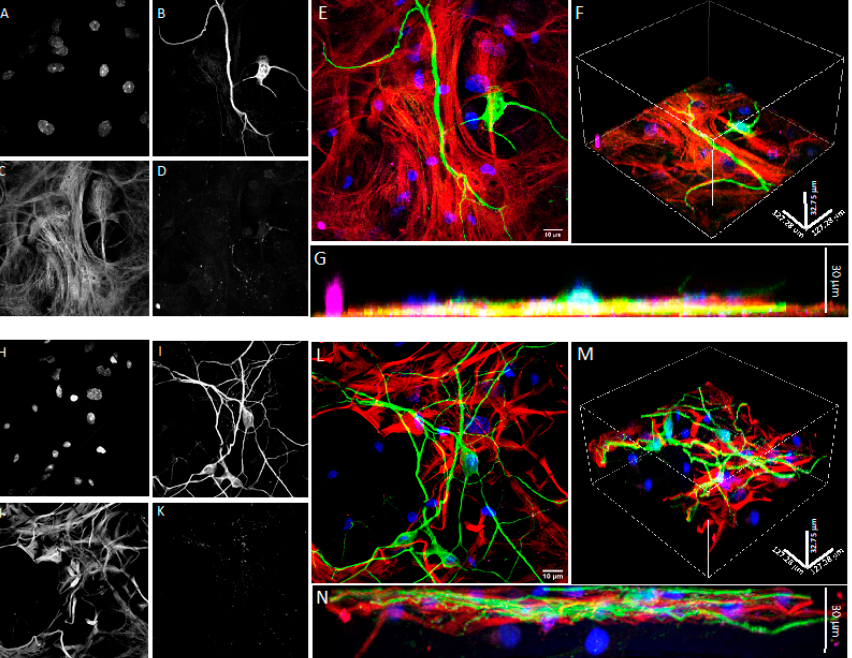
Figure 8. Confocal microscopy of DIV21 hippocampal co-cultures of astrocytes and neurons in 2D and in the 3D synthetic microscaffold Nichoid. ( A – D ) Grayscale images from horizontal sections of 2D hippocampal astrocyte and neuron co-cultures marked with Hoechst ( A ), MAP2 ( B ), GFAP ( C ), and PSD95 ( D ). ( E ) Merged fluorescence image of 2D co-culture with Hoechst in blue, MAP2 in green, GFAP in red, and PSD95 in violet. ( F , G ) Lateral views of the 2D co-cultures displayed in ( E ). ( H – K ) Grayscale images of horizontal sections of 3D hippocampal co-cultures of astrocytes and neurons marked with Hoechst ( H ), MAP2 ( I ), GFAP ( J ), and PSD95 ( K ). ( L ) Merged fluorescence image of the 3D hippocampal co-cultures with Hoechst in blue, MAP2 in green, GFAP in red, and PSD95 in violet. ( M , N ) Lateral view of 3D co-cultures displayed in L. Images were taken with a 100× (oil immersion) objective.